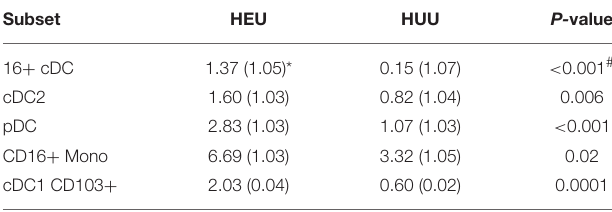
TABLE 2 | APC subsets significantly different between 27 HEU and 17